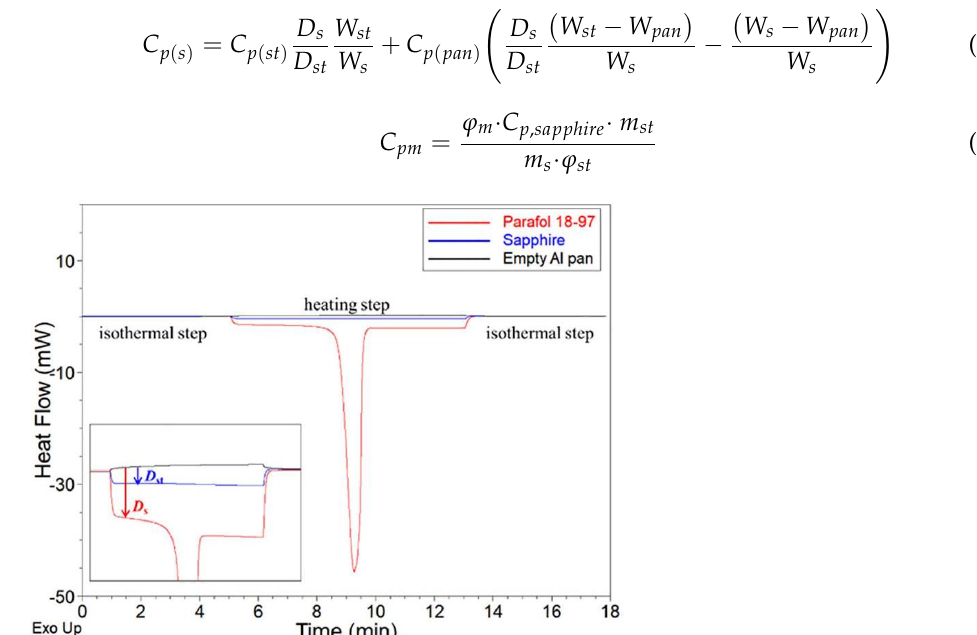
Figure 15. Three steps in Cp measurements for Parafol 18 – 97, after